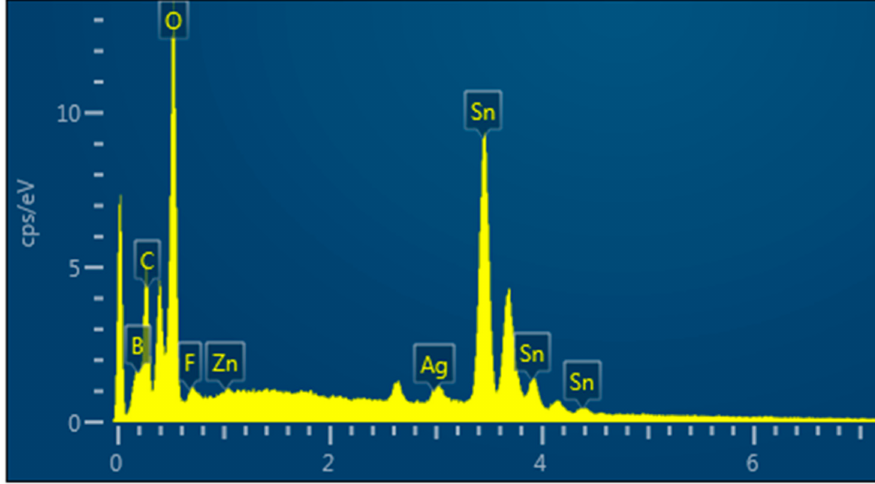
Figure 3. Energy dispersive spectroscopy (EDS) of the B/Ag/F tridoped SnO 2 -ZnO